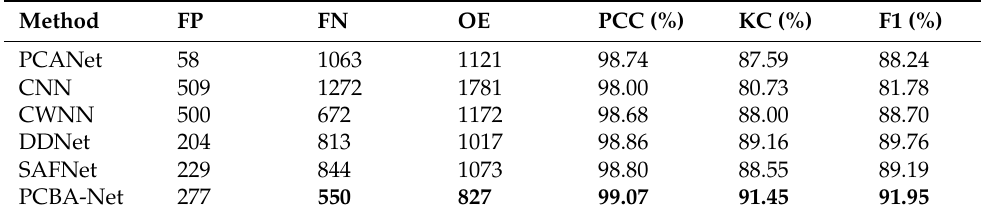
Figure 16. Visualization of comparative experiments for the Yellow River C dataset. ( a ) Ground-truth image. ( b ) Result of PCANet. ( c ) Result of CNN. ( d ) Result of CWNN. ( e ) Result of DDNet. ( f ) Result of SAFNet. ( g ) Result of the presented PCBA-Net. Table 7. Change detection results for Yellow River C dataset. Table 5. Change detection results for Yellow River A